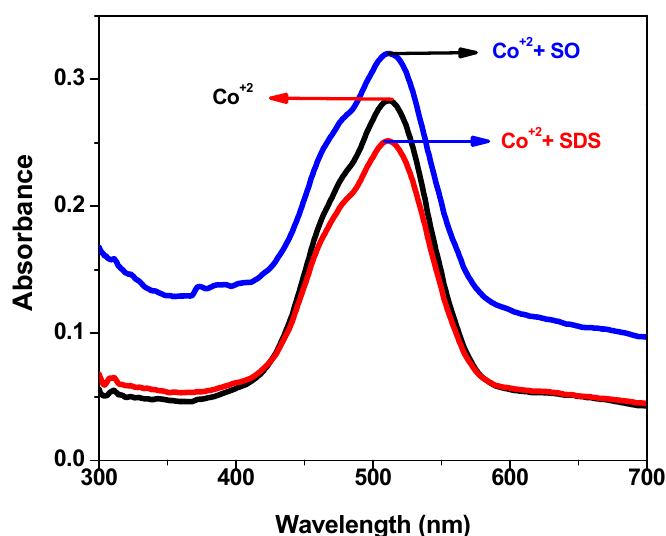
Figure 1. Simple absorption spectra of CoCl 2 in the presence and absence of surfactant